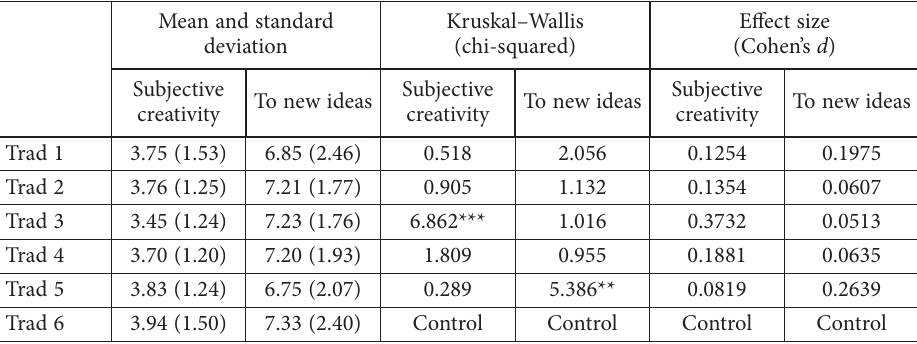
Table 4. Mean scores, Kruskal–Wallis one-way analysis of variance and Cohen’s d (source: created by authors)